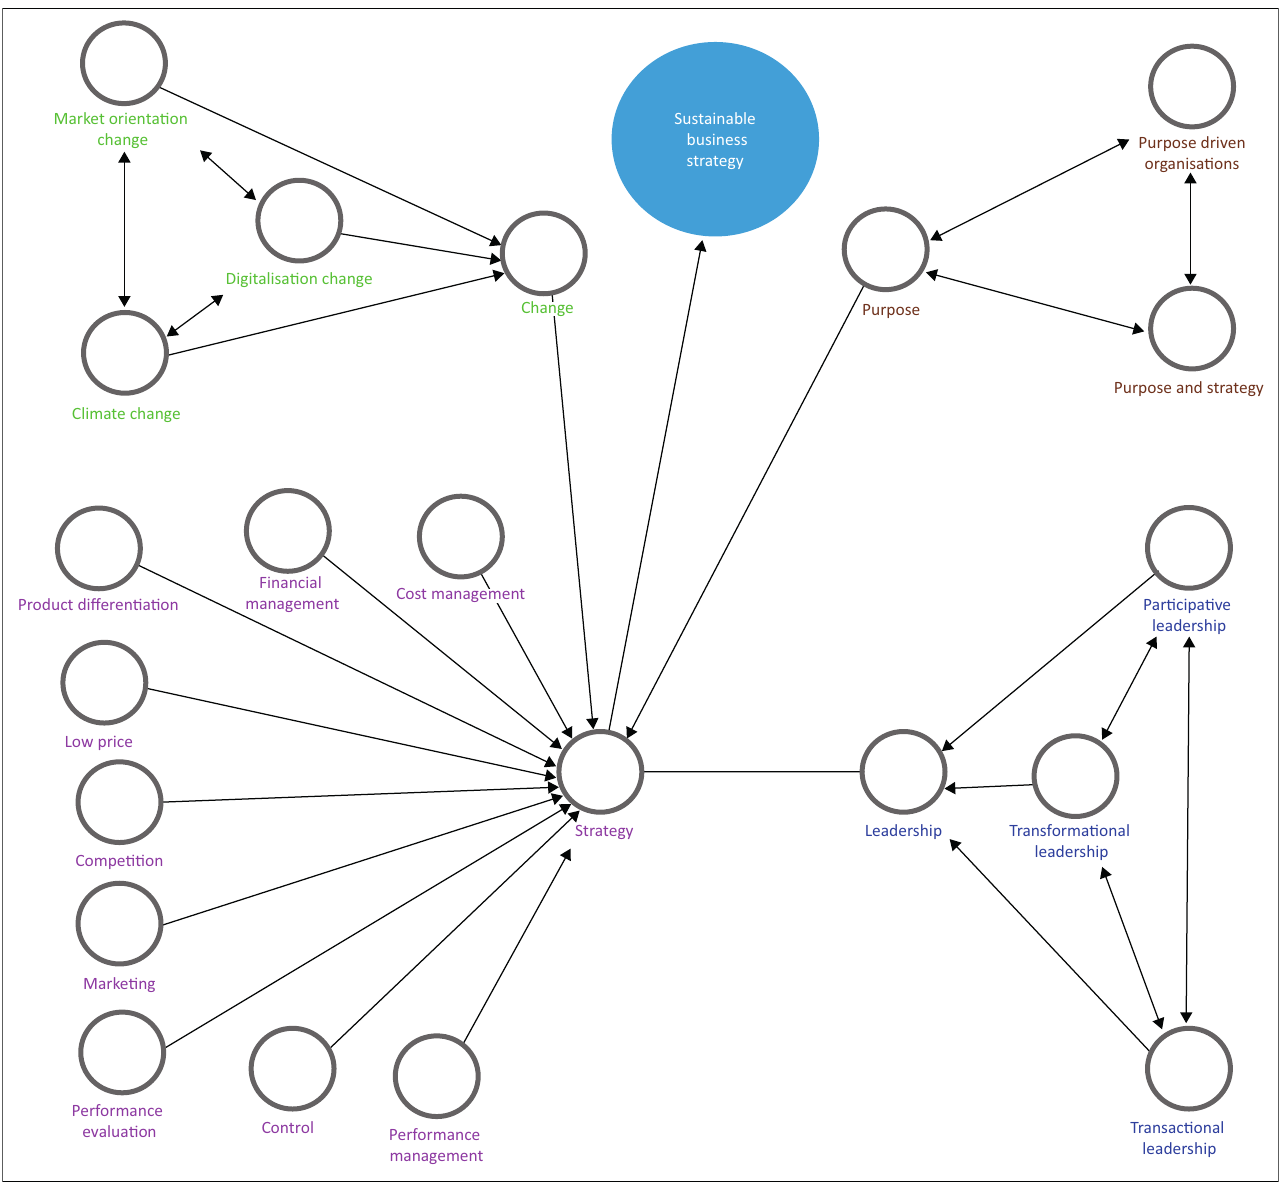
FIGURE 3: Conceptual map (Nvivo™/®/© version 12). TABLE 2: New growth strategy and change in business environment (SPSS™/®/© version 27).